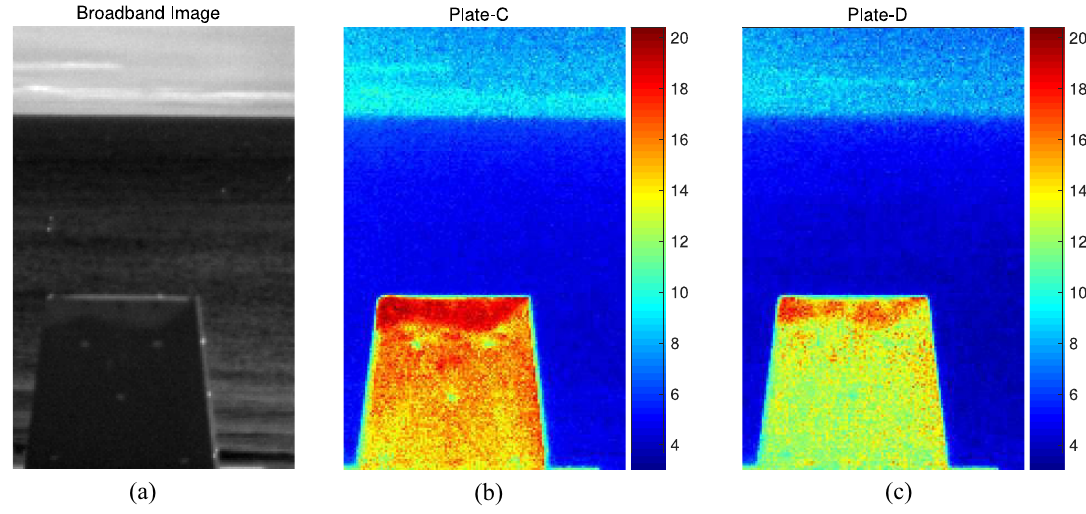
Figure 15. Thermal stealth application of a remote temperature estimation: ( a ) broadband image; ( b ) temperature distribution of Plate-C; ( c ) temperature distribution of